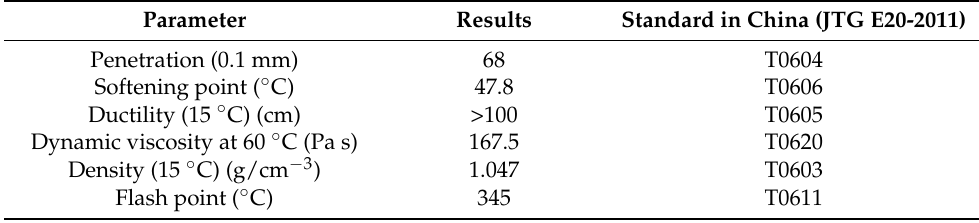
Table 1. Properties of base asphalt.